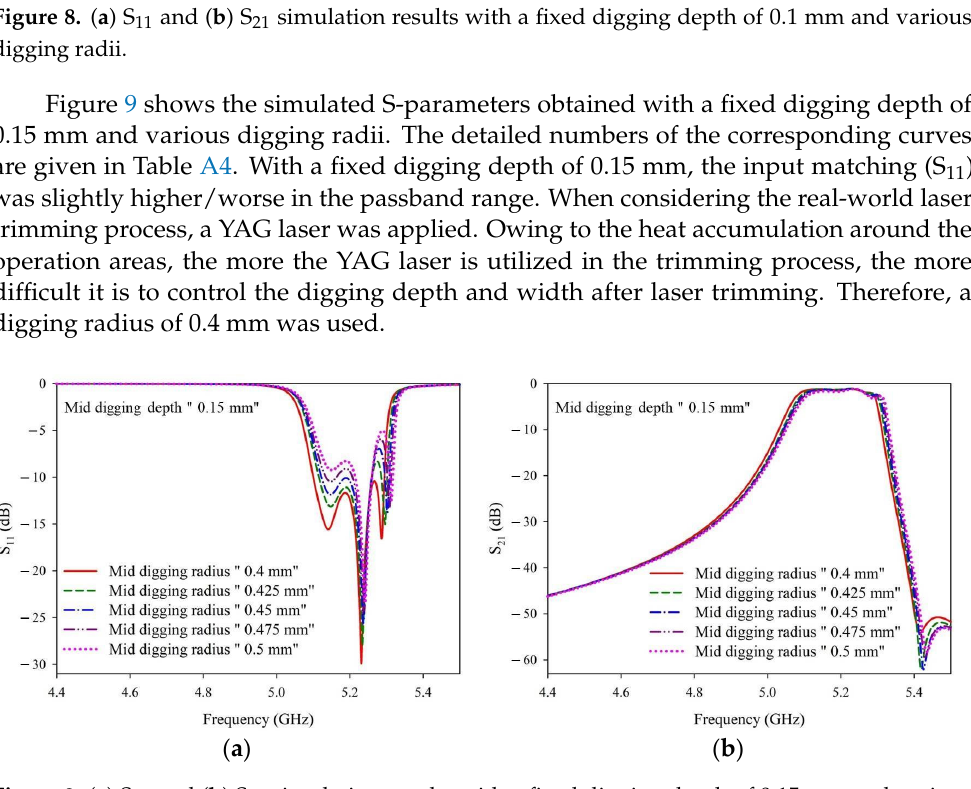
Figure 9. ( a ) S 11 and ( b ) S 21 simulation results with a fixed digging depth of 0.15 mm and various digging radii.